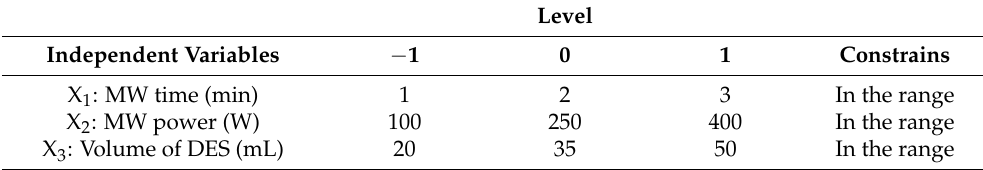
Table 1. Variables and levels in Box-Behnken experimental design for PET